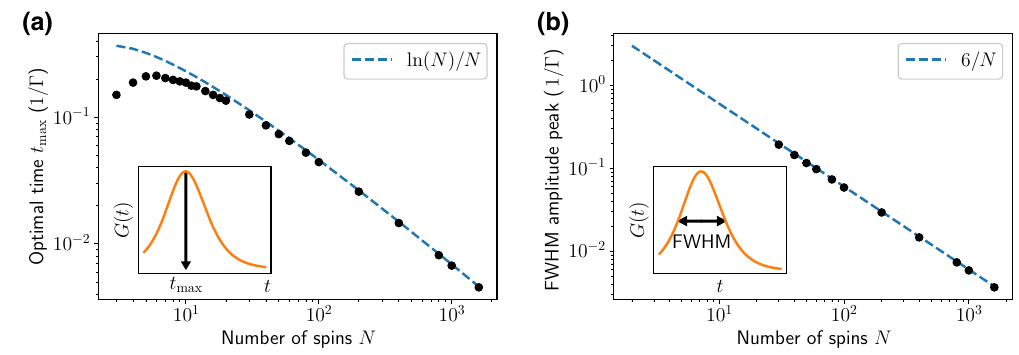
FIG. 2. (a) The optimal time t max that maximizes the time-dependent gain G ( t ) defined in Eq. (10). (b) The full width at half maximum of the time-dependent gain G ( t ) . In both panels, the black circles are obtained by a numerically exact solution of the collective relaxation dynamics generated by the master equation (3) for γ rel /(cid:5) = 0. The blue dashed lines indicate fits of the large- N results based on the scaling laws derived using mean-field